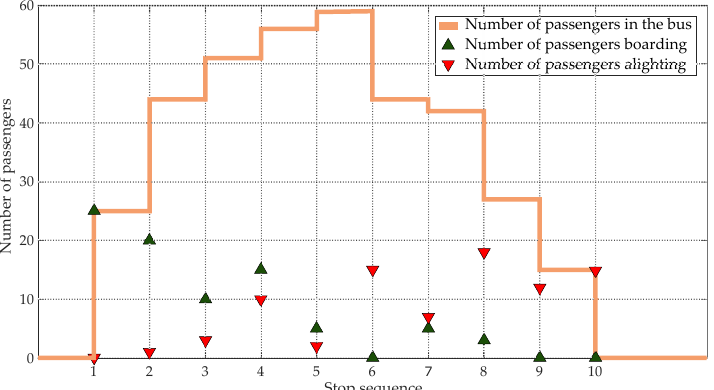
Figure 7. Number of passengers boarding, alighting, and on the bus at each stop of route n°1.